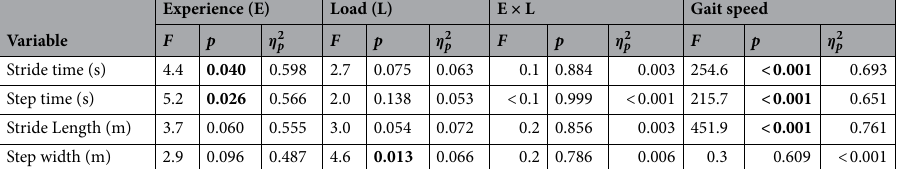
Table 3. Analysis of covariance results for mean gait measures. The table presents the F statistics, p- values, and effect sizes for the main effects of experience level (E: 1st-year vs. 4th-year) and load condition (L: Load Zero vs. Load Low vs. Load High ), and the interaction effect of experience level and load condition (E × L). The effect of the covariate (gait speed) is also included. Significant effects are highlighted in bold. When reporting p -values, if the value was smaller than 1 in one thousand, instead of reporting the exact p -value up to the first significant decimal figure, we followed standard statistical abbreviation and reported it as p < 0.001.